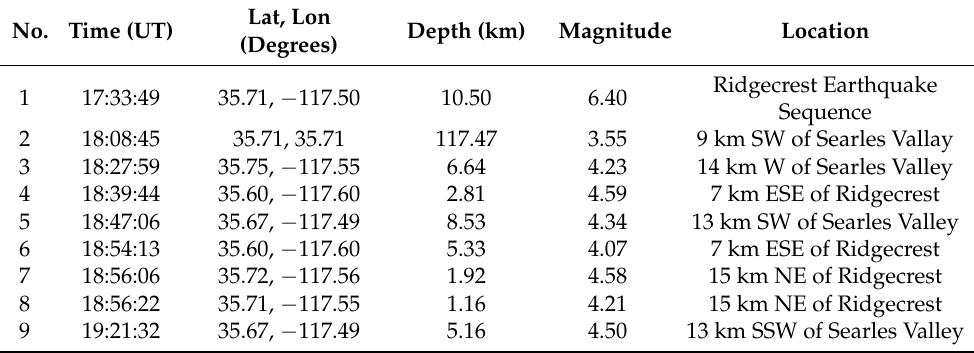
Table 1. Selected earthquakes of the Ridgecrest sequence, USGS database, magnitude ≥ 3.55, 4 July 2019, California,